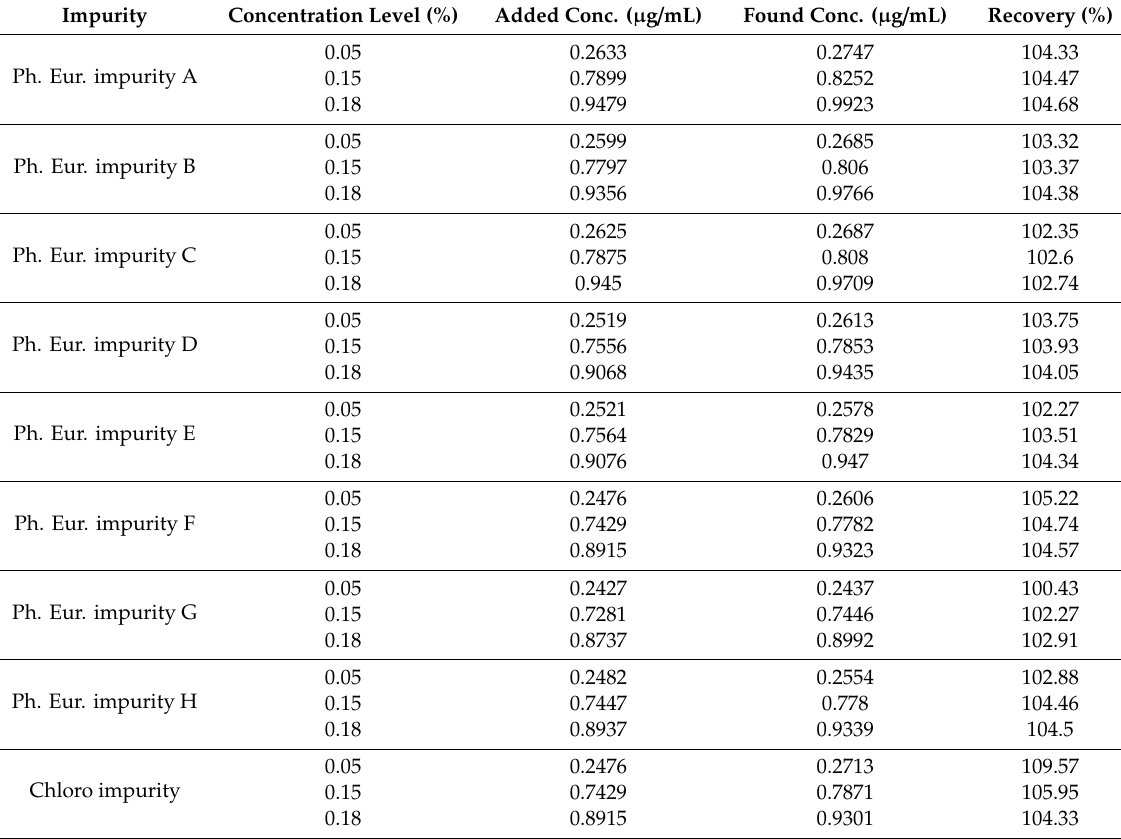
Table 7. Results of recoveries of ropinirole impurities investigated at three concentration